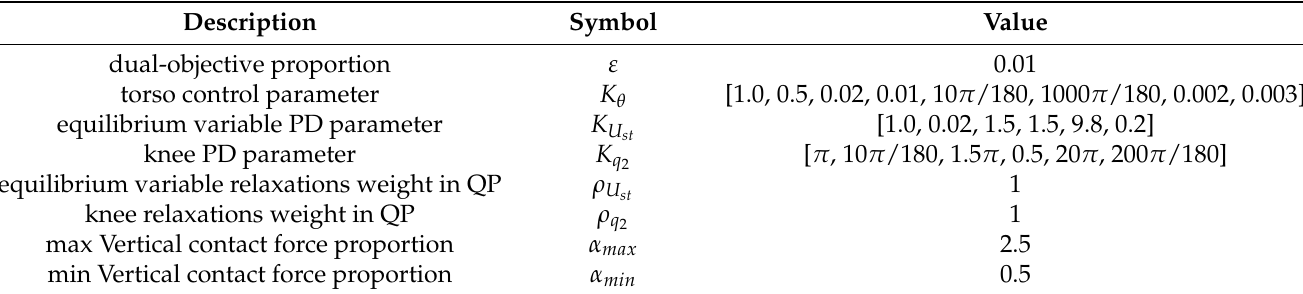
Figure 15. Snapshots of the posture recovery when the robot stands on ground with a low-friction coefficient. Table 3. Control parameters in